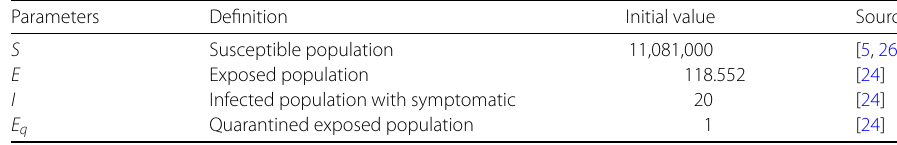
Table 2 Definition and initial values of variables of the